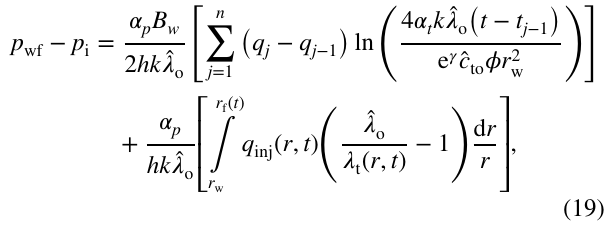
Fig. 1 Mobility ratio > 1— injection